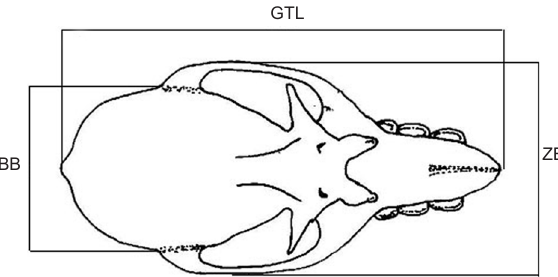
Figure 4. Dorsal view of the skull of Pteropus giganteus